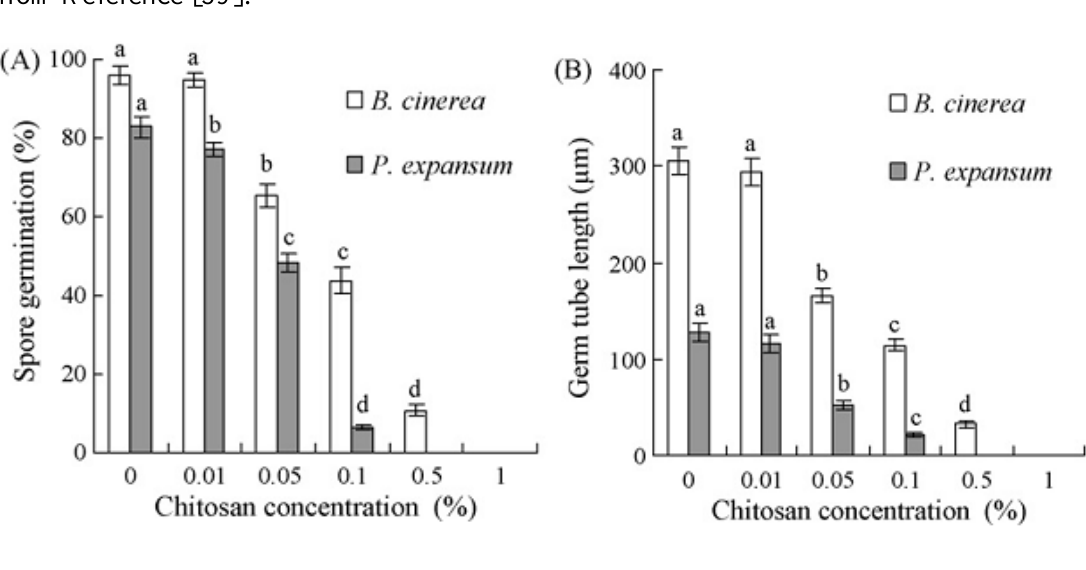
Figure 8. Effects of chitosan concentration on spore germination ( A ) and germ tube elongation ( B ) of Botrytis cinerea and Penicillium expansum 12 h after incubation at 25 °C. Bars represent standard deviations of the means. Values followed by different letters are significantly different according to Duncan’s multiple range test at P < 0.05. Reproduced from Reference